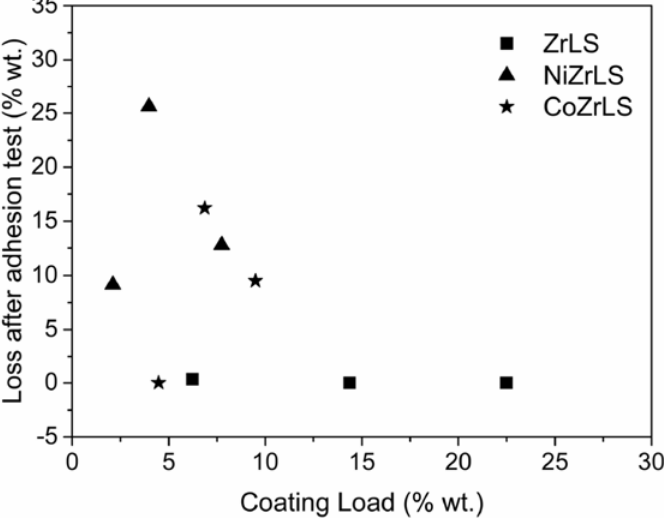
Figure 7. Weight loss after adhesion test for Zr-based samples as a function of load after